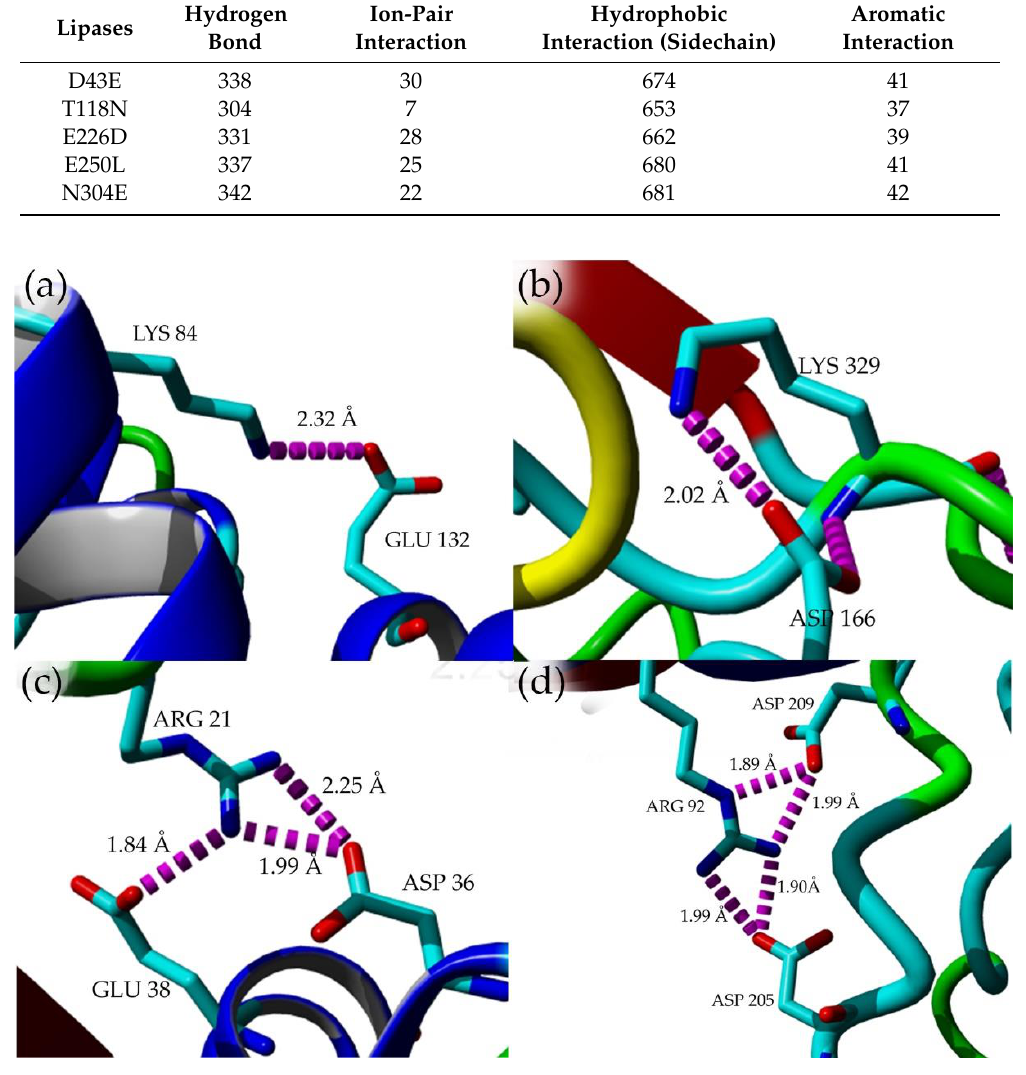
Figure 8. Ion-pair interaction in mutant structures. ( a ) Ion-pair interactions in D43E mutant structure between amino acid Lys84 – Glu132 ( b ) Ion-pair interactions in D43E mutant structure between amino acid Lys329 – Asp166 ( c ) Ion-pair network in D43E mutant structure comprising amino acids Glu38, Arg21, and Asp36. ( d ) The largest ion-pair networks in E226D structure corresponding to amino acids Asp209, Arg92, and Asp205. Ion-pair interaction colored in magenta. The figure was generated using YASARA software [20].